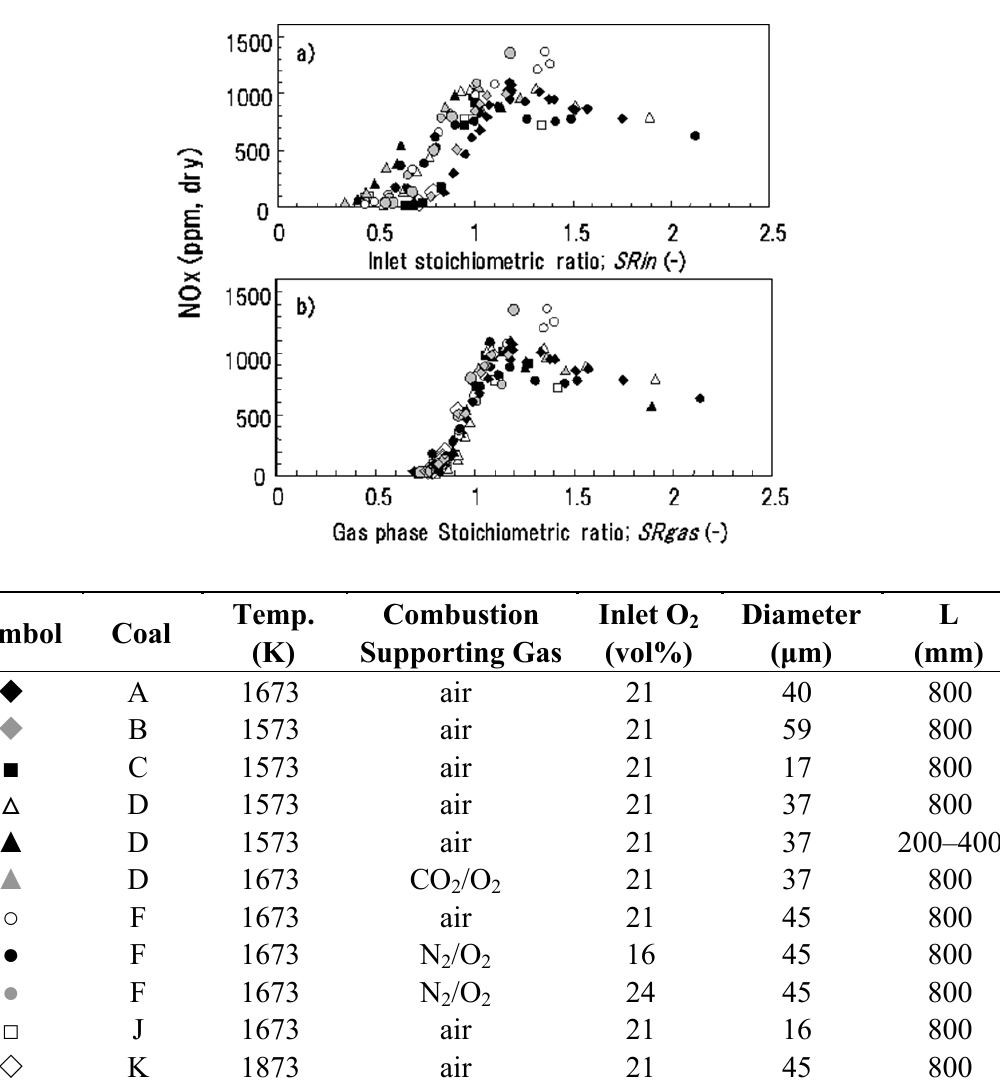
Figure 2. Relationship between gas phase stoichiometric ratio and NO